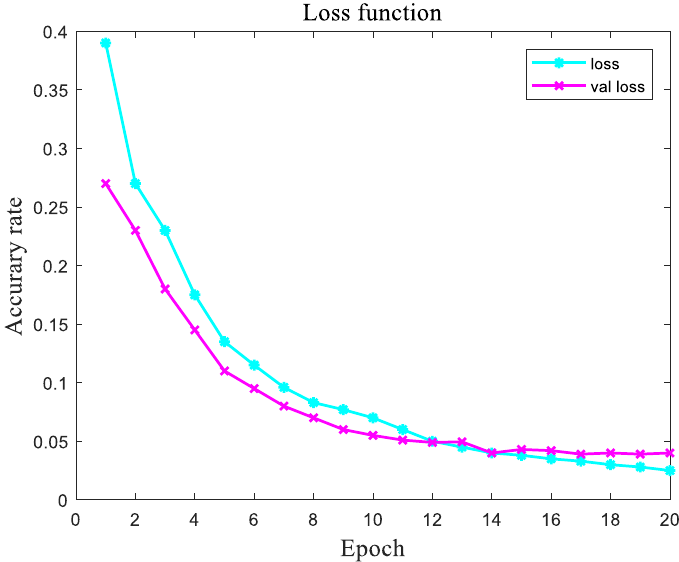
Figure 6. Loss functions for training and test sets.